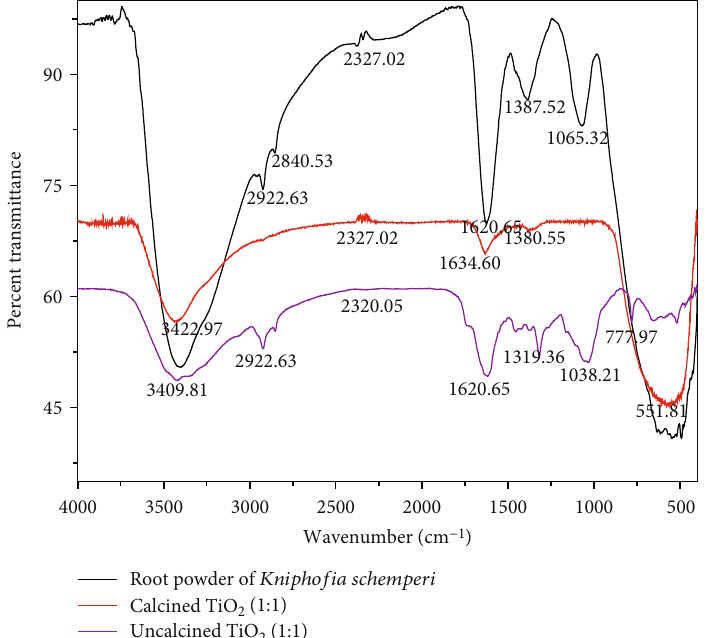
Figure 10: FT-IR spectra of root powder of Knipho fi a schemperi (a), calcined TiO